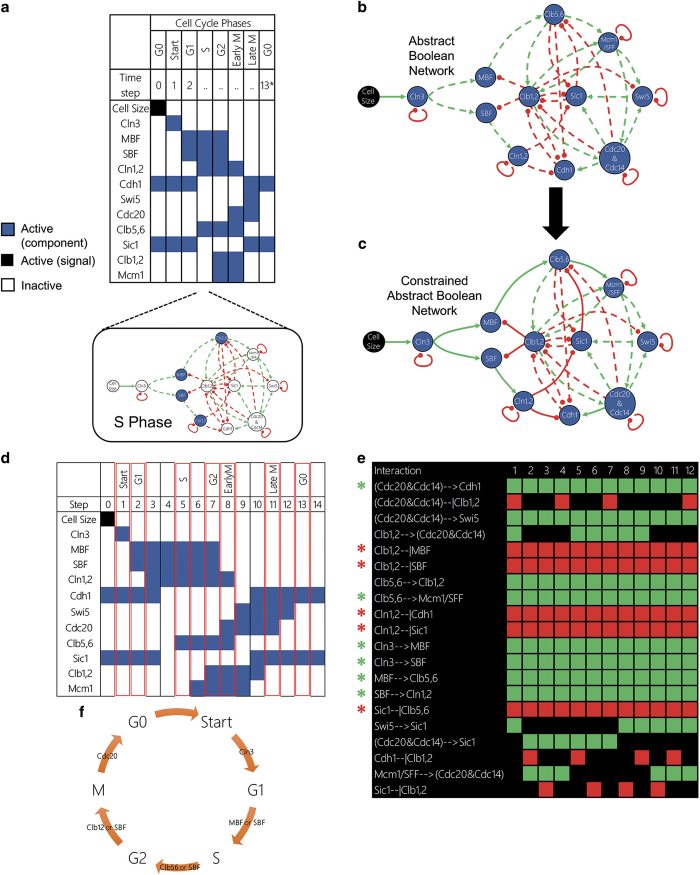
Studying the biological program governing the cell cycle in budding yeast. (a) The order of the cell cycle phases upon perturbation of G0 due to activating cell size, before the system stabilizes in G0 (indicated by a star). An example of S phase is visualized graphically on the network diagram. (b) The ABN constructed from the Yeast model proposed by Li et al. (c) The cABN satisfying the cyclic constraint in (a). 11 required interactions are indicated by solid arrows (in addition to the definite activation of Cln3 by cell size). (d) Example trajectory taken by one solution when the G0 state is perturbed by activating cell size. The step at which each cell cycle phase is reached is indicated. (e) There are 12 minimal networks, each consisting of 20 instantiated possible interactions. Green indicates an activation, red indicates a repression, and asterisks indicate required interactions. Some of these mechanisms do not require all components to behave as regulators (Mcm1, Cdh1 and Swi5). In addition, some sets of interactions expose redundancy: for example, six concrete models do not require Swi5 to regulate Sic1, which is instead activated by Cdc20. In the remaining models, Swi5 is required to activate Sic1 in the absence of activation by Cdc20. (Similarly, the activation of Cdc20 by Clb12 or Mcm1, and the inhibition of Clb12 by Cdc20, Cdh1 or Sic1.) (f) The set of consistent mechanisms can be used to predict perturbations that arrest the cell cycle. In each case, loss of function of the gene highlighted on the arrow will prevent the transition from occurring.